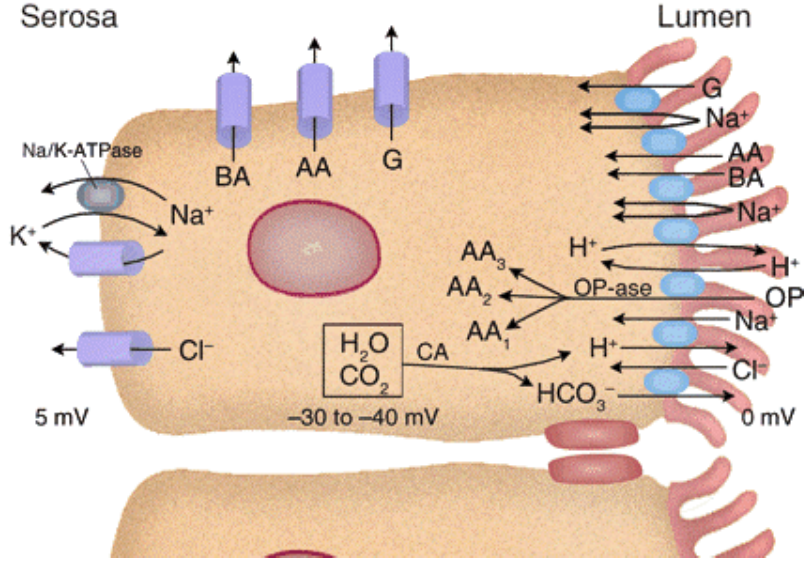
FIGURE 1 . Ileal absorptive cell, multiple-brush border transporters couple ion influxes (Na + and H + ) to organic solute influxes or exchange for bicarbonate; cellular H + and HCO 3– extruded in exchange for Na + and Cl – is provided through the action of carbonic anhydrase (CA). Additional HCO 3– may enter the cell through the basolateral membrane NHE1 or the Na/HCO 3 cotransporter (not shown). (Reprinted from Field[14] with